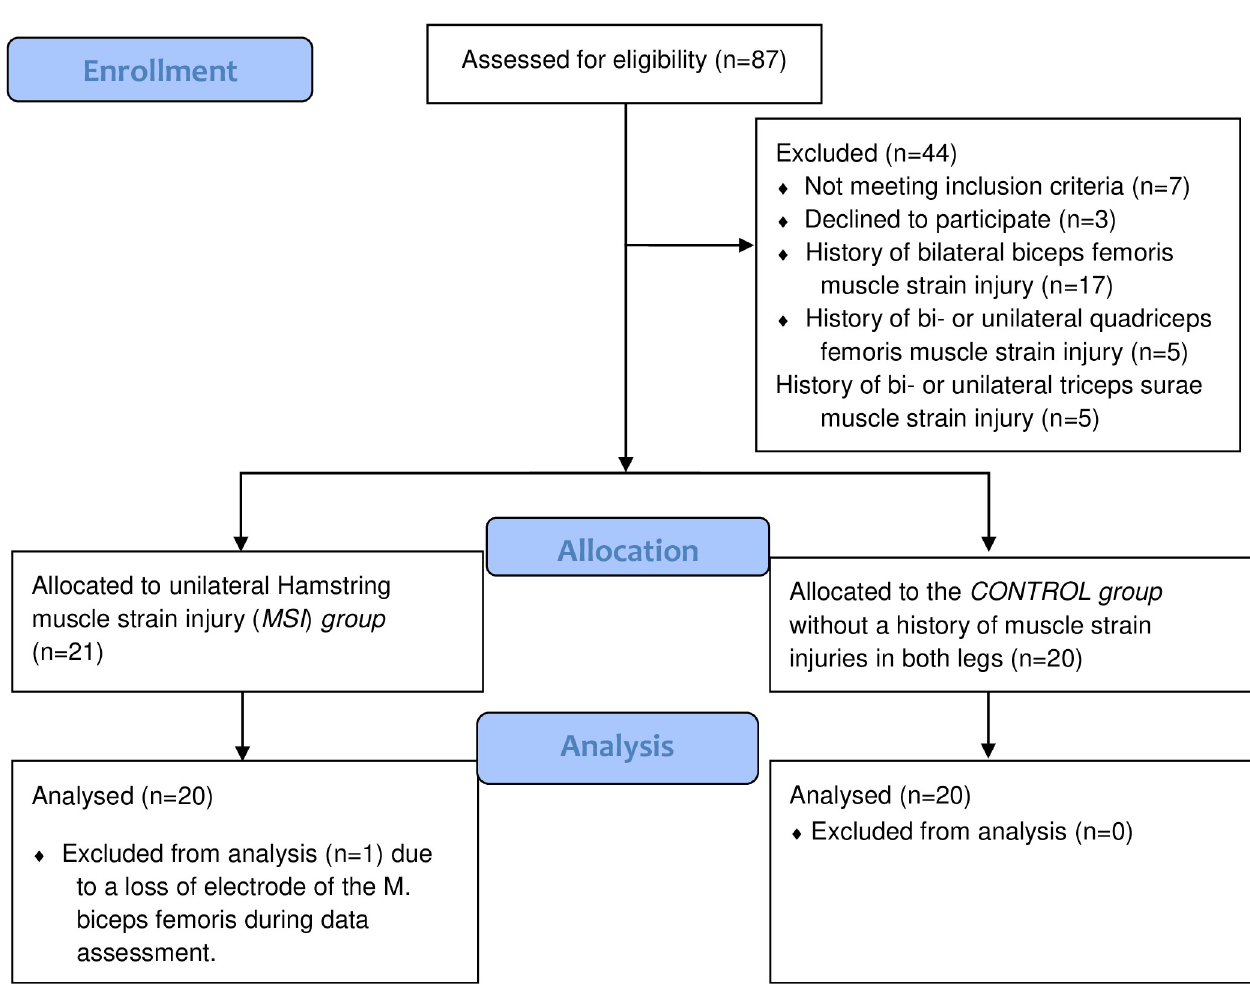
Fig 1. CONSORT flow chart diagram. Enrollment procedures and sample